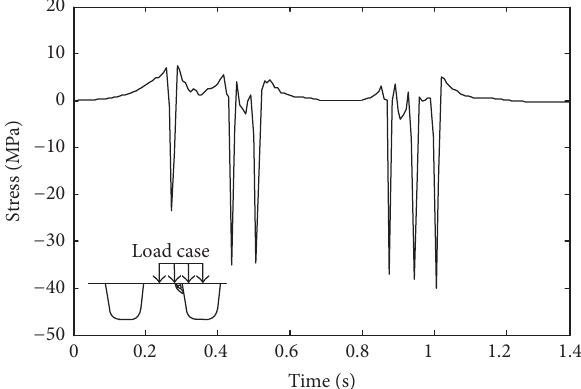
Figure 8: Stress-time curves of welded details of the steel box-girder under 𝑉 6 load.